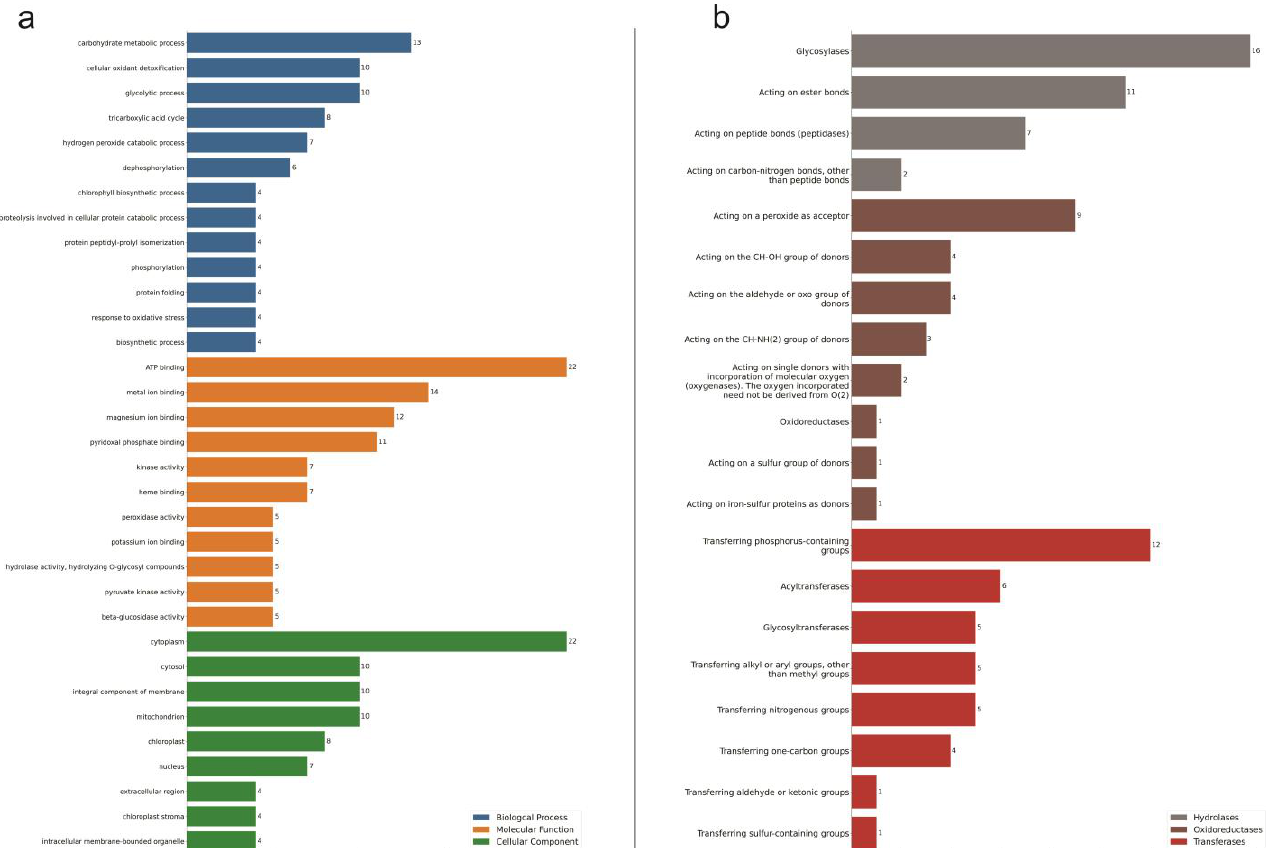
Figure 2. Gene Ontology (GO) annotation classification statistics graph from proteome in the leaves of young oil palm plants under drought stress. Classified accordingly to biological process, cellular component, and molecular function ( a ); and to chemical reactions by which proteins are classified according to EC. Only the most populated groups per GO term, and only the three prevalent classes of enzymes are shown ( b ). Numbers represent the amount of positive hits.